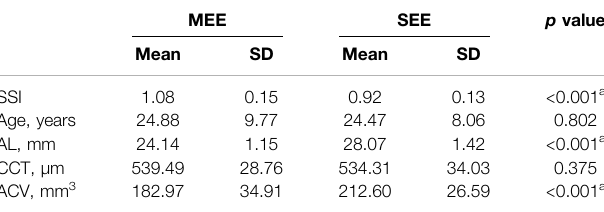
TABLE 3 | Comparison of parameters between two